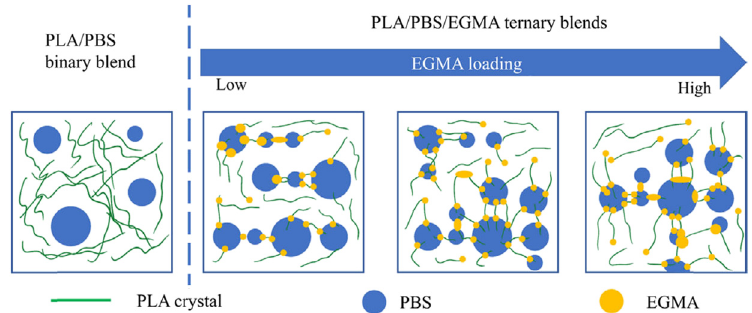
Figure 10: Schematic of the morphological evolution of PLA/PBS blends in the presence of di ff erent loadings of EGMA ( 78 ) . Copyright 2020. Reproduced with permission from John Wiley and